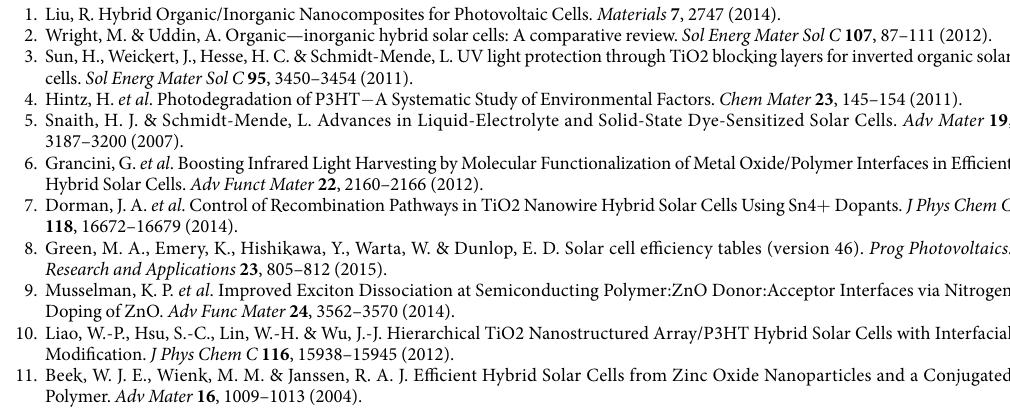
parameters such as the effective mass, the static dielectric constant, and the energy level distribution of the traps 61 . The slope as well as the vertical axis intersection point are increased for 1 and 2 mol% doped samples and thus, the factor τ N c is enhanced. For a 3 mol% doping concentration this factor is decreasing again. In general, a higher doping concentration should result in a larger number of mobile electrons in the conduction band (increased N c ) such that an increased slope points to an enhanced scattering time τ .